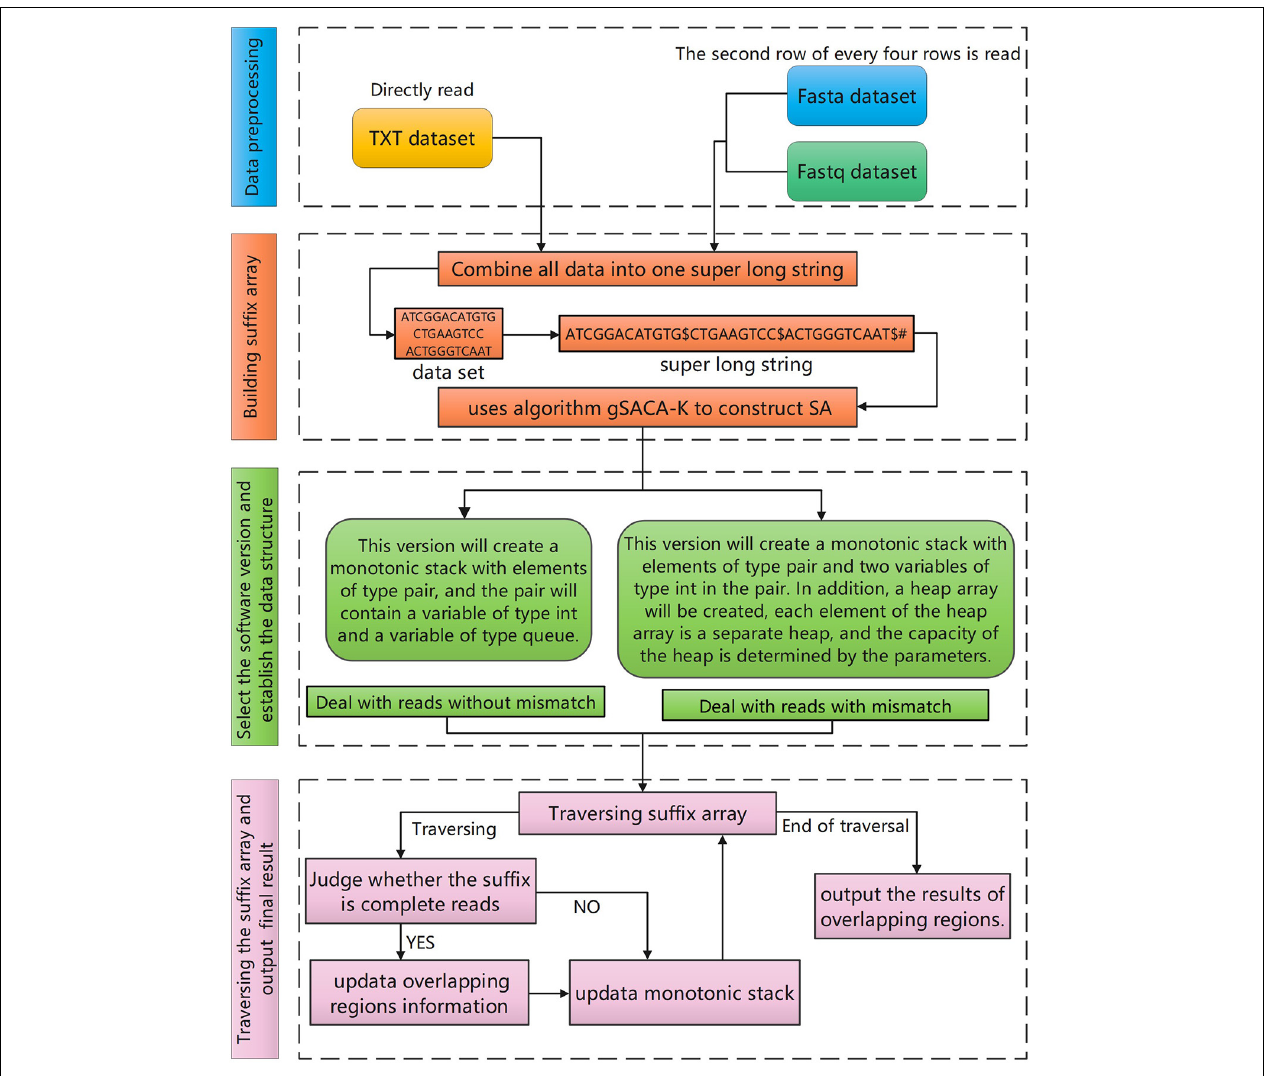
FIGURE 1 | The overall workflow of the